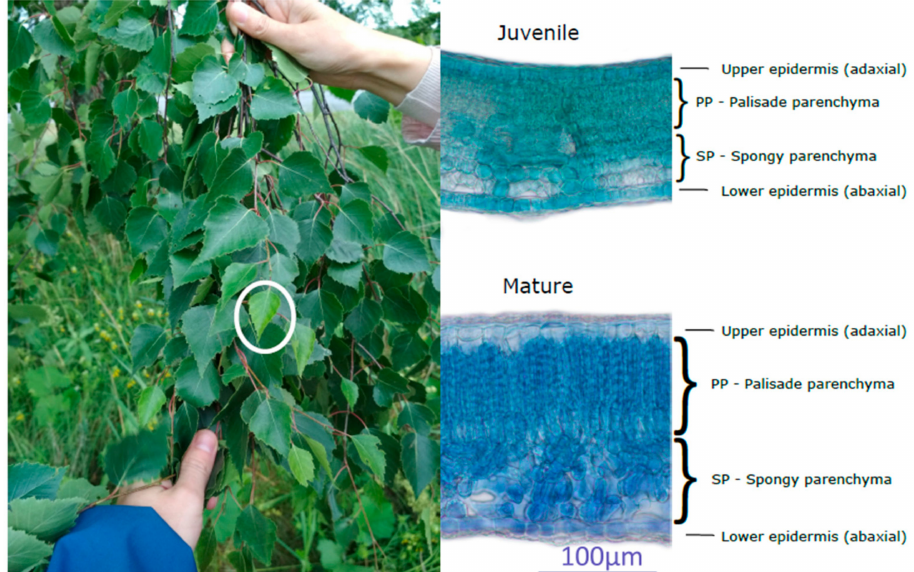
Figure 1. Branch of B. pendula during taking ground truth in 25 June (right photo). White circle mark juvenile appearance of the leaf surrounded by mature leaves. In the middle cross-sections of two developmental stages (juvenile and mature) of B. pendula leaves sampled in June (18 June = DOY 169). (Right) description of leaf internal structure with a description of leaf tissues that were quantified in the present study. Palisade and spongy parenchyma comprise the photosynthetic mesophyll tissue. Dermal tissue is represented by the adaxial epidermis on the upper surface and abaxial epidermis on the lower surface. Fresh hand sections stained with toluidine blue, bright field microscopy, magnification 400 ×